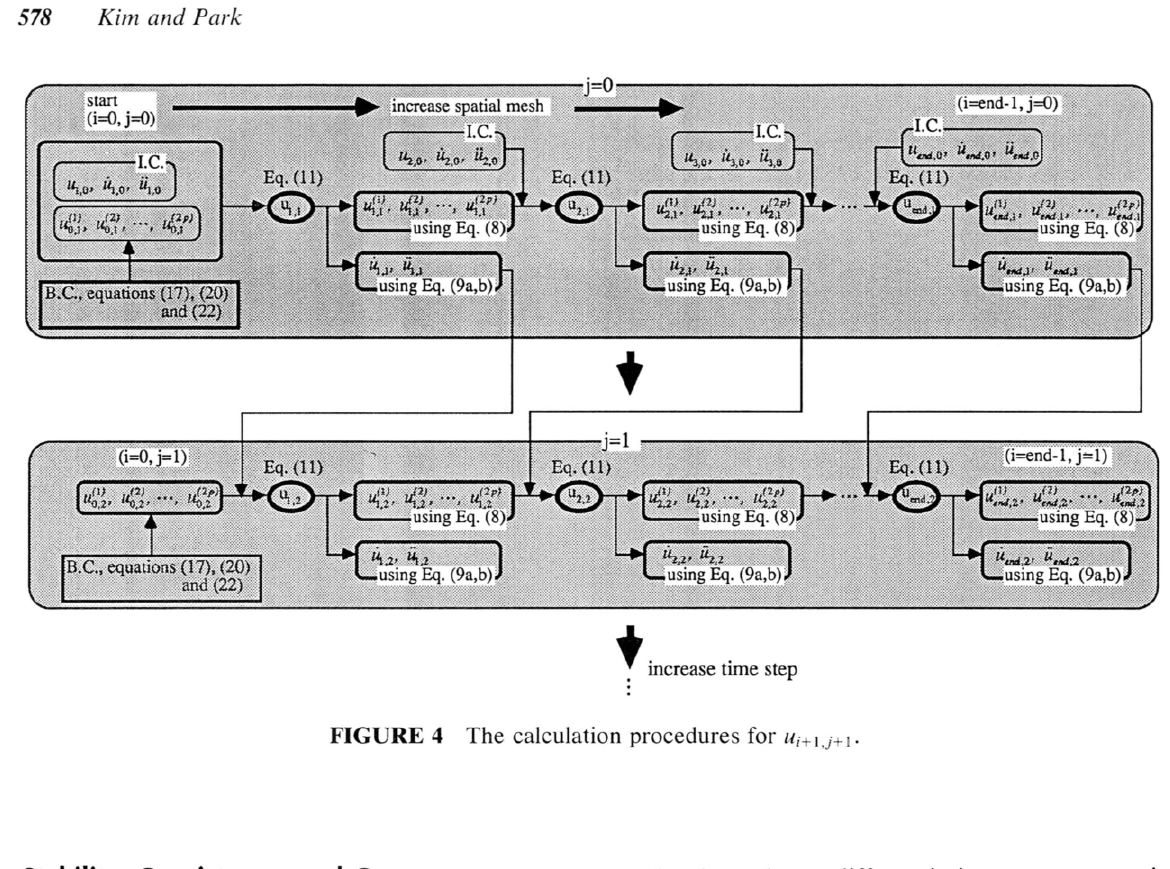
FIGURE 4 The calculation procedures for Ui+l,j+l